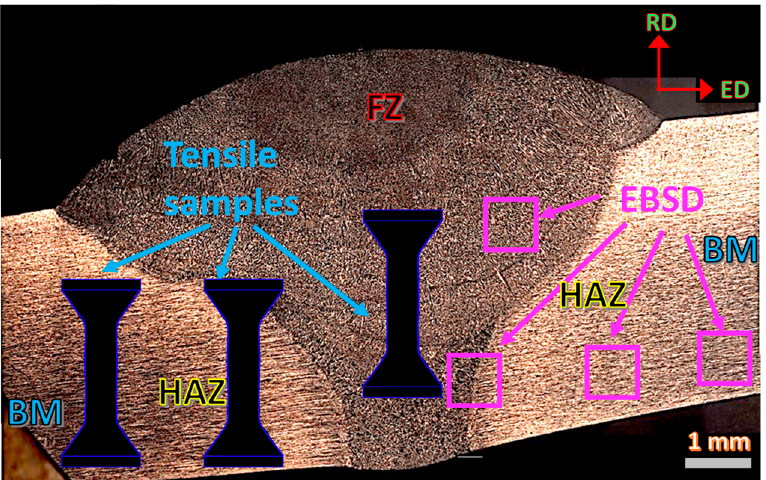
Figure 2. Analyzed zones on the weld seam with indication of the areas were mini-tensile samples were extracted (all the tensile samples were cut with the same orientation; the tensile test drawings are scaled 1:2).